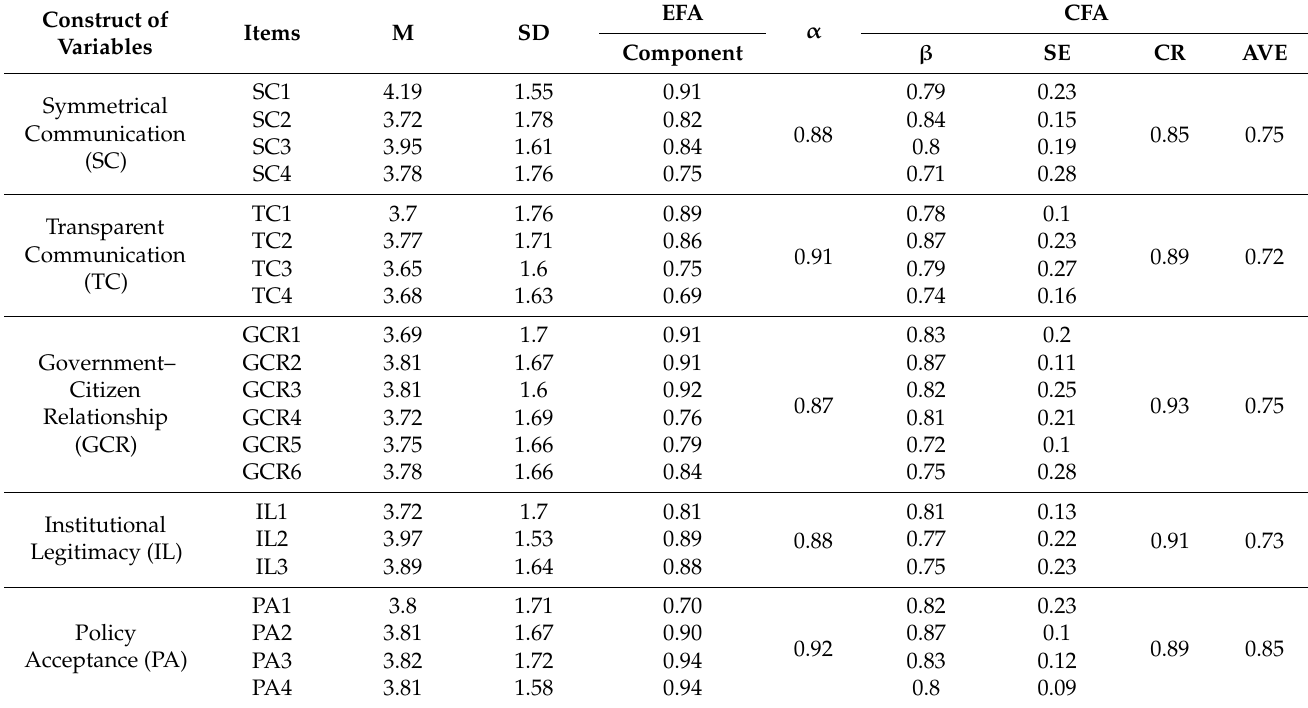
Table 2. Exploratory factor analysis (EFA), Cronbach’s α , and confirmatory factor analysis (CFA) results of the variables.